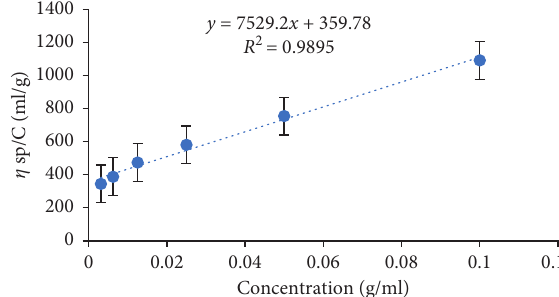
Figure 8: Relation between η sp/C and concentration of pure chitosan